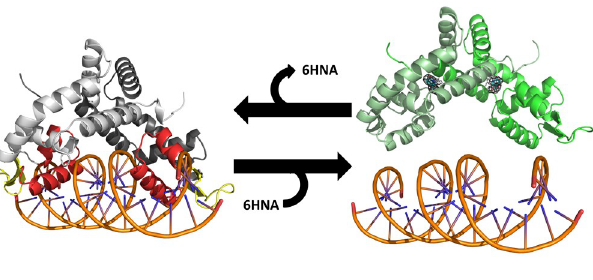
Fig 6. Model for regulation of BpsR regulation. BpsR binding of 6HNA produces a conformational change in the protein that reduces DNA binding